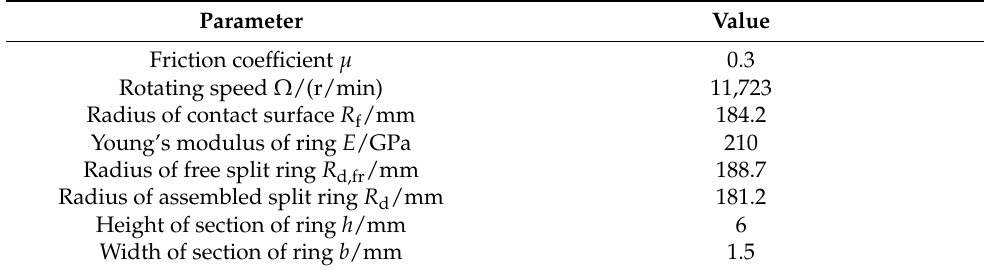
Figure 16. Schema of parameters for the system. Table 2. Parameters for the blisk ‐ ring system.